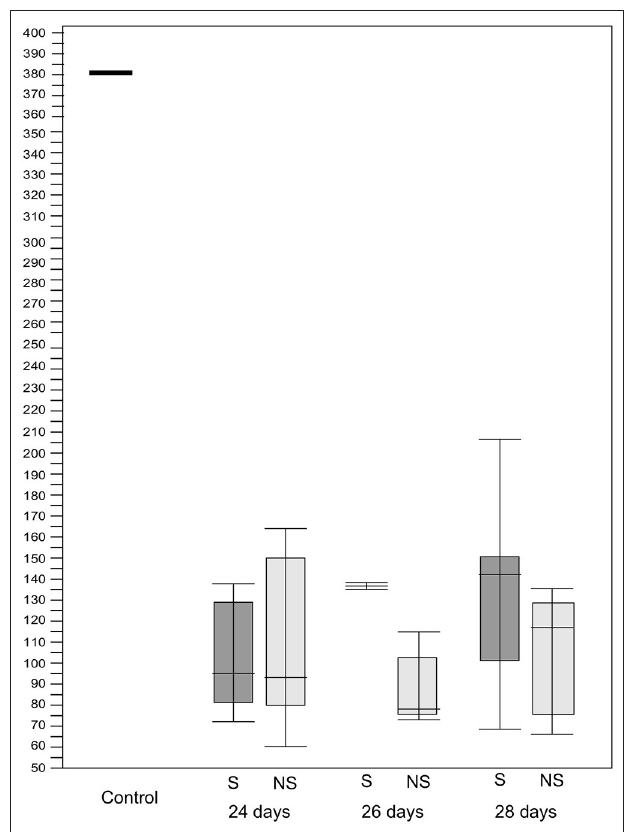
FIGURE 1 | Box–Whisker plot showing the difference in villi height between the spermine–treated and non–spermine groups in the immature intestines. The median of the spermine–treated group was higher than the non–spermine groups in three treated periods, namely 24, 26, and 28 days, though this difference was not statistically significant. For details, see the